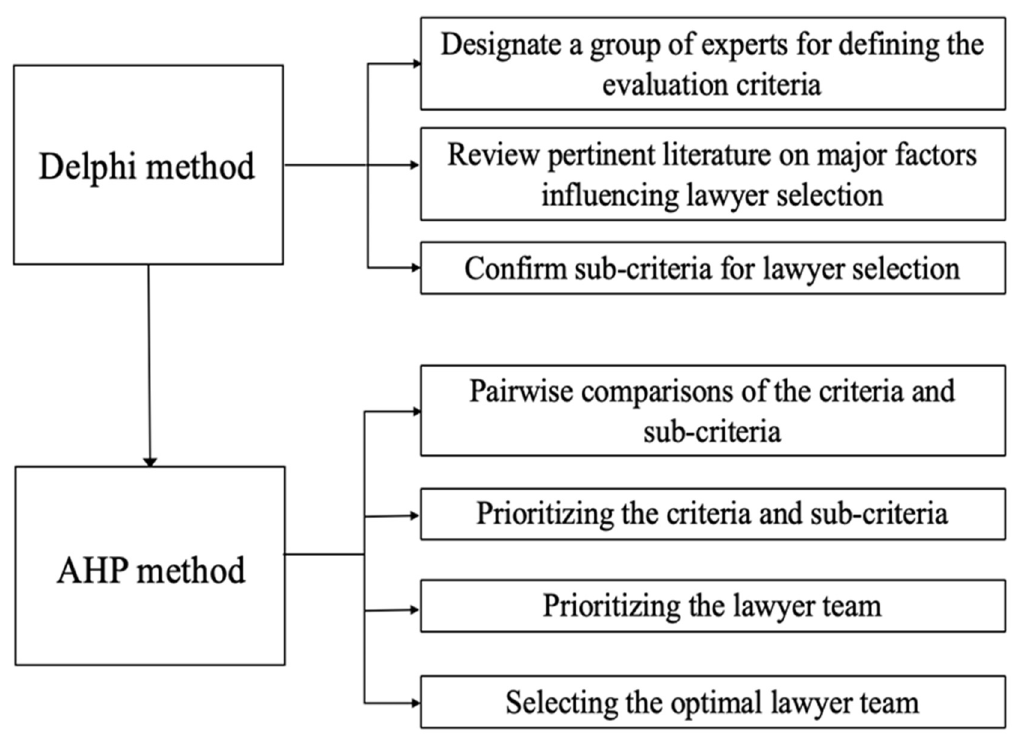
Figure 1. Framework for the proposed approach.